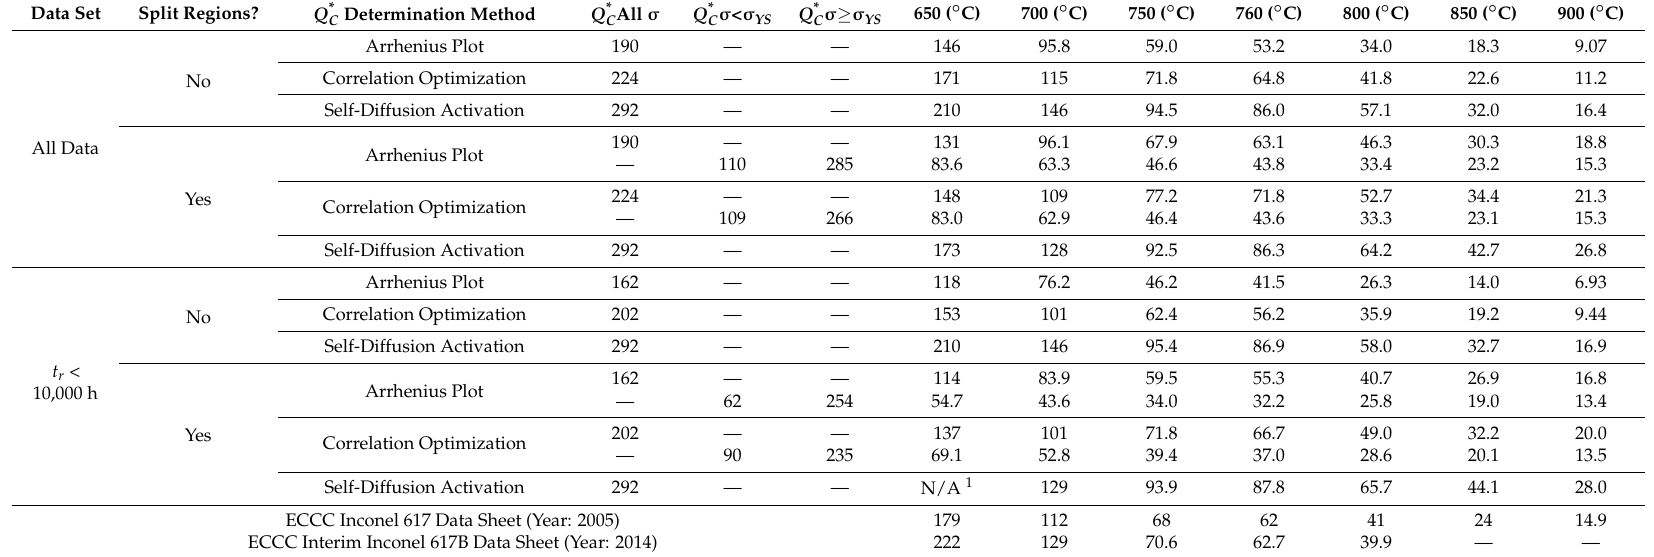
Table 7. Calculated creep strength for rupture of Inconel 617 at 100,000 h